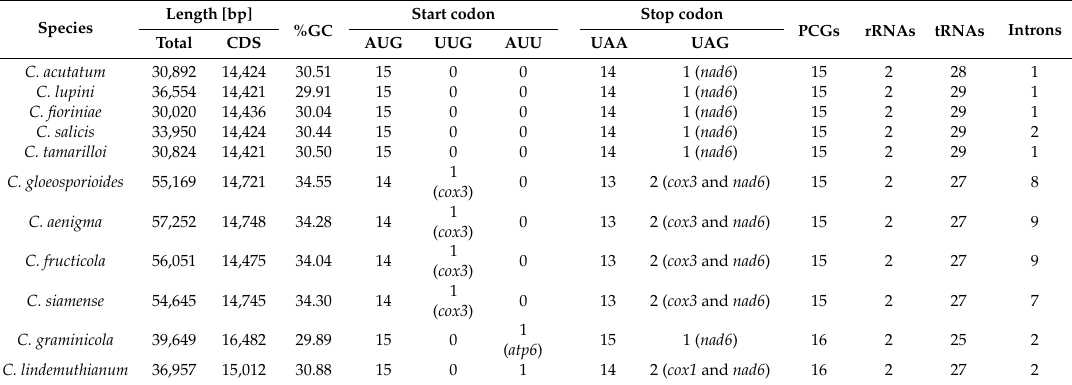
Table 2. General features of the mitochondrial genomes of selected Colletotrichum species.